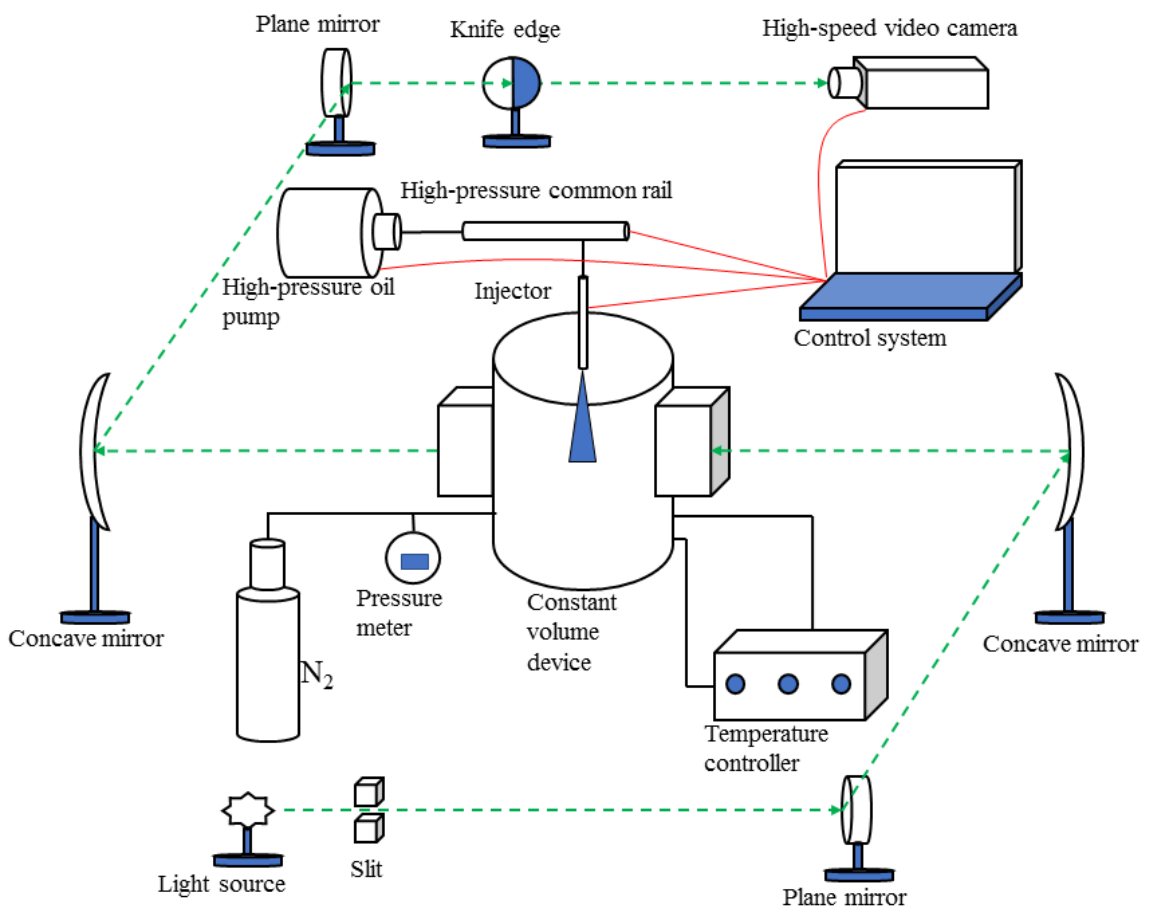
Figure 1. Scheme of the schlieren experiment.